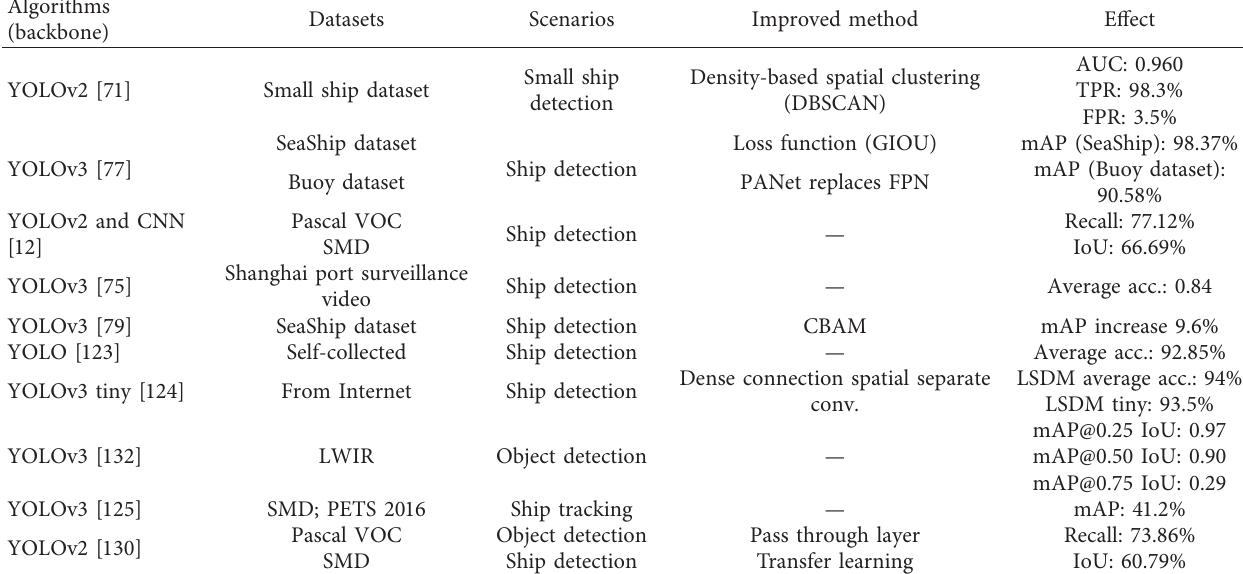
Table 2: Application of improved YOLO backbone network in maritime object detection.